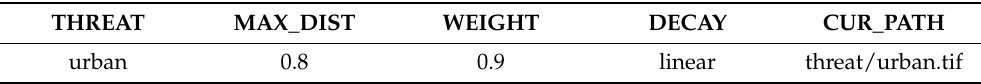
Table 3. Habitat Quality modelling. Threat values in the input .csv table. The abbreviation MAX_D˙IST stays for the maximum distance at which the threats generates a decay on habitats, while CUR_PATH stays for the file path where the current land-use scenario is saved in the system.